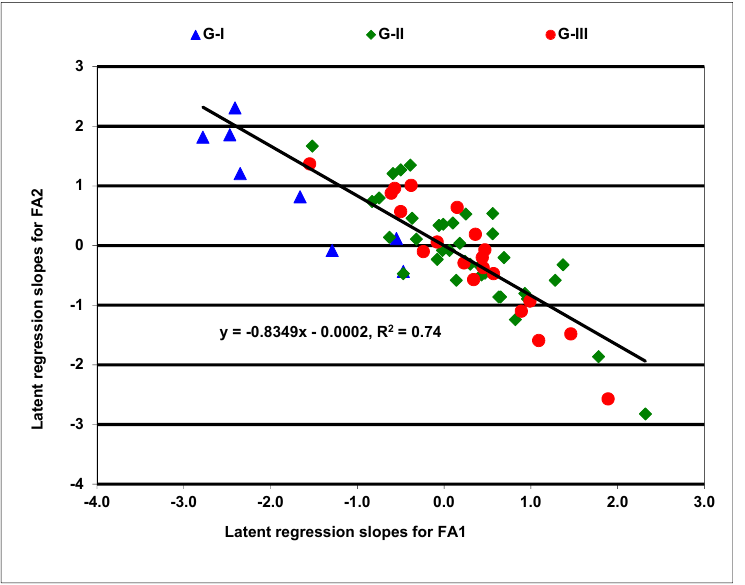
Figure 2. Latent regression line slopes of the first two factors for provitamin A content of maize hybrids were obtained from a factor analytic model. Those marked blue belong to the first group (G-I), those marked green are included in the second group (G-II), and those marked red represent the third group (G-III).